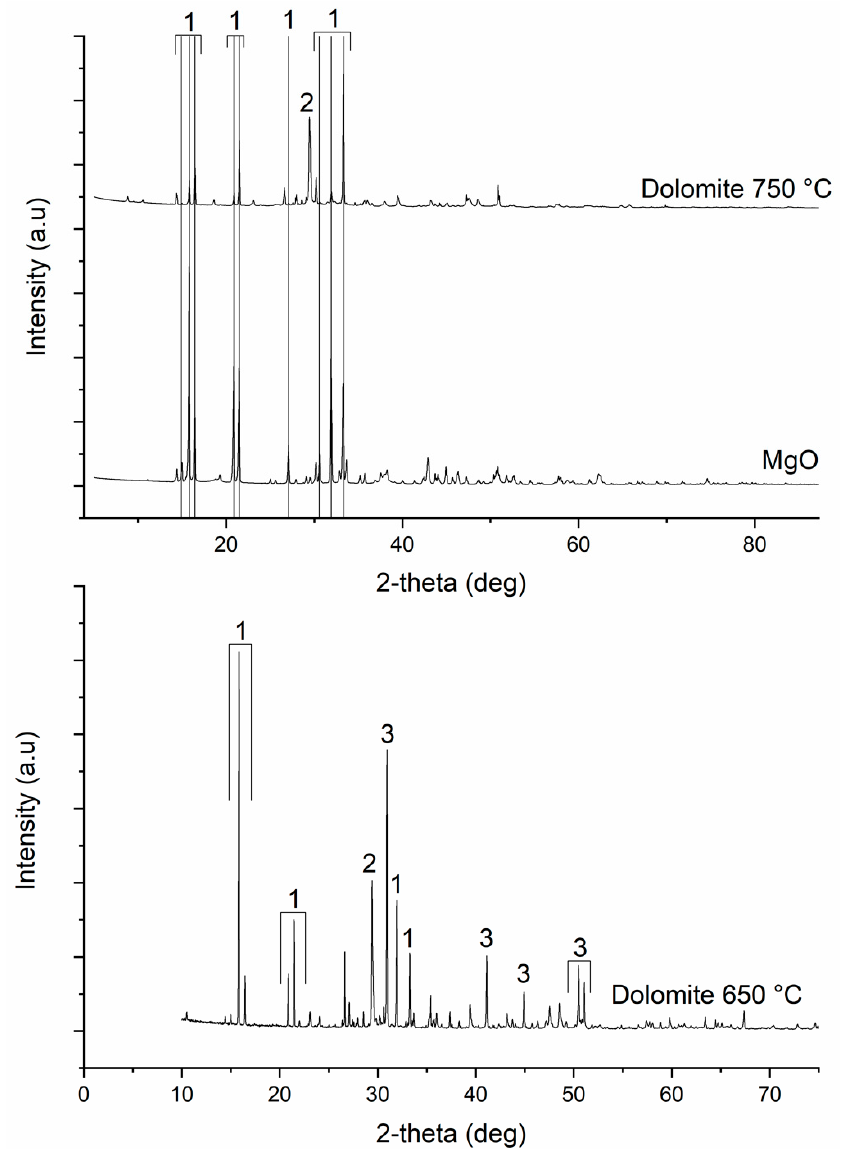
Figure 7. XRD di ff ractograms of the precipitates after the 24-h experiments (Mg:P:N 1.3:1:2 for MgO and 1.3:2:2 for dolomite 650 ◦ C and 750 ◦ C): 1 = NH 4 MgPO 4 · 6H 2 O; 2 = CaCO 3 ; 3 = (CaMg(CO 3 ) 2 . SEM images of the precipitates (Mg:P:N = 1.3:1–2:2) are portrayed in Figure 8a,b for MgO